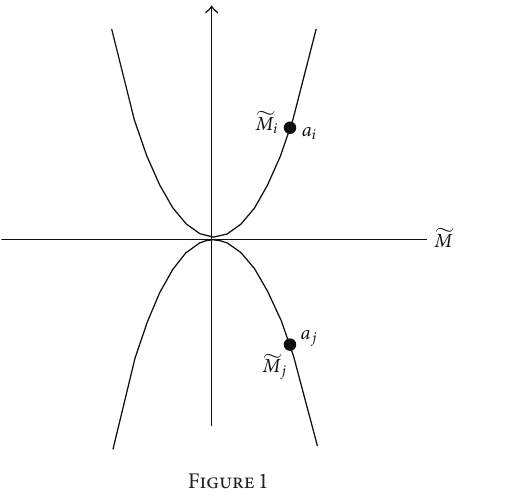
̃𝑀 ̃𝑀 such that 𝜇 𝑖 = 𝜇 𝑗 𝑗 down